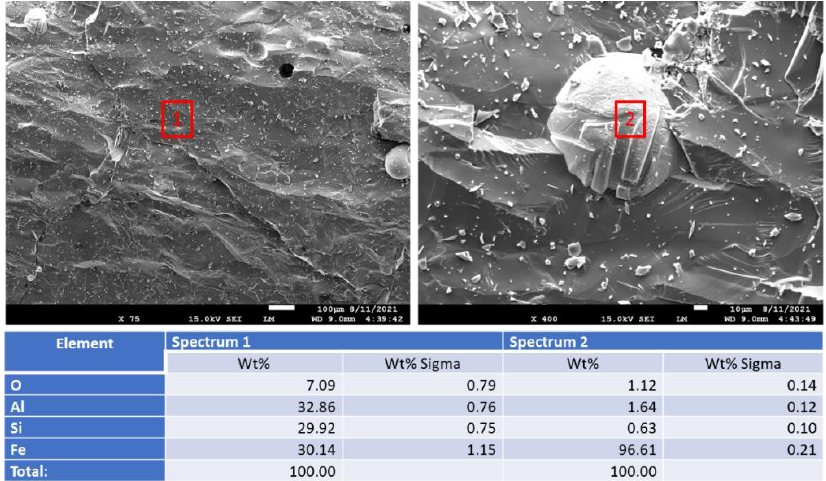
Figure 32. Photomicrographs of mullite samples with the elemental composition of typical sites shown by the red boxes after 3 cycles of thermal shock (one cycle: 600 ◦ C heat → cold water